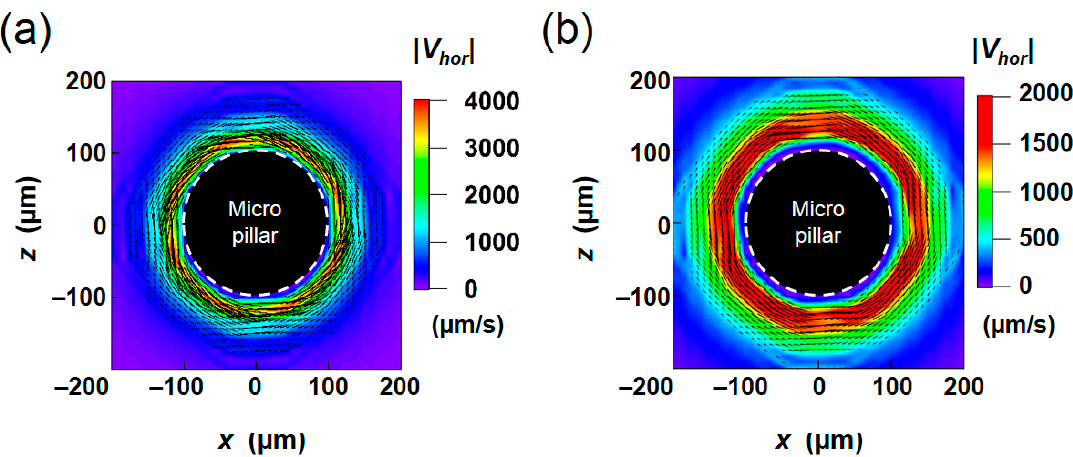
Figure 7. 2D vector plots of the averaged velocity flow field calculated by the ( a ) Eulerian and ( b ) Lagrangian approaches.